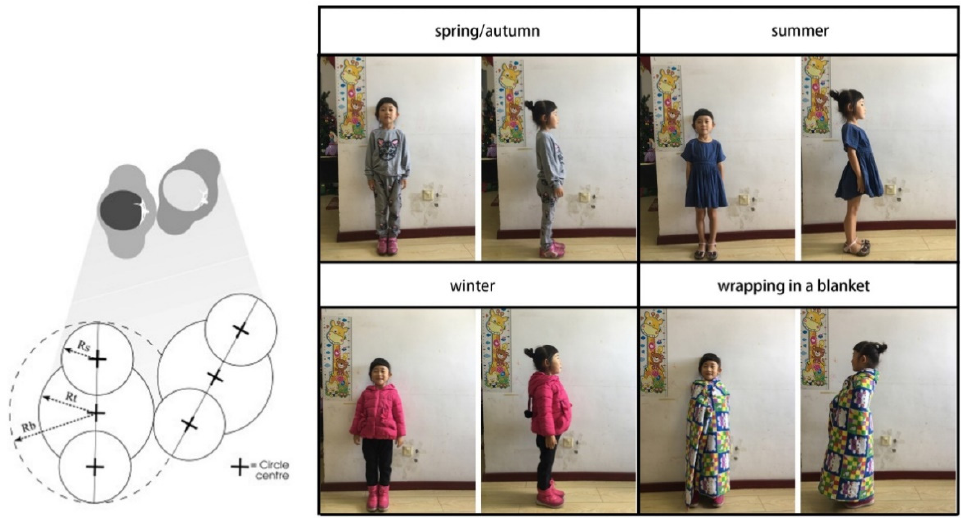
Figure 4. Size of agent and children’s clothing in different seasons. Table 2. Specific sizes of clothes worn by children in different seasons and scenarios.